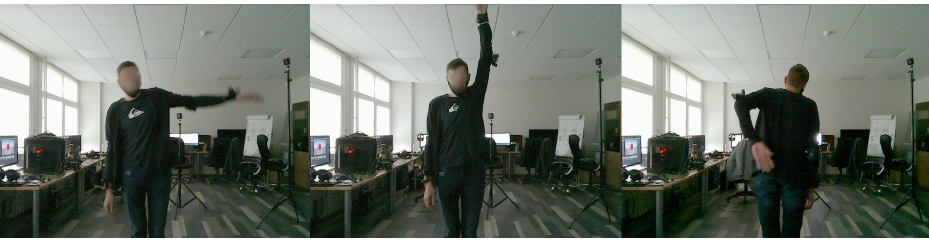
Figure 5. Dataset example. Table 1. Real-world dataset breakdown captured for a single perspective selfie video (average distribution for different